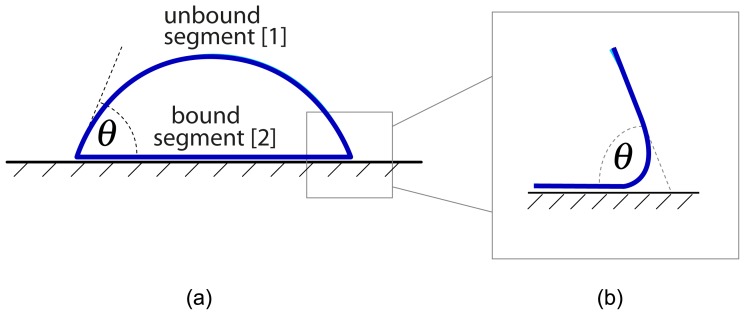
(a) Side view of a vesicle that strongly adheres to a planar substrate surface. The vesicle membrane (blue) consists of two segments: the unbound segment
S[1] that forms a spherical cap with surface area
A[1] and the bound segment
S[2] with surface area
A[2]. The two segments meet along the contact line with effective contact angle θ = θeff; and (b) When viewed with increased resolution, the unbound membrane segment close to the contact line is smoothly curved [36].